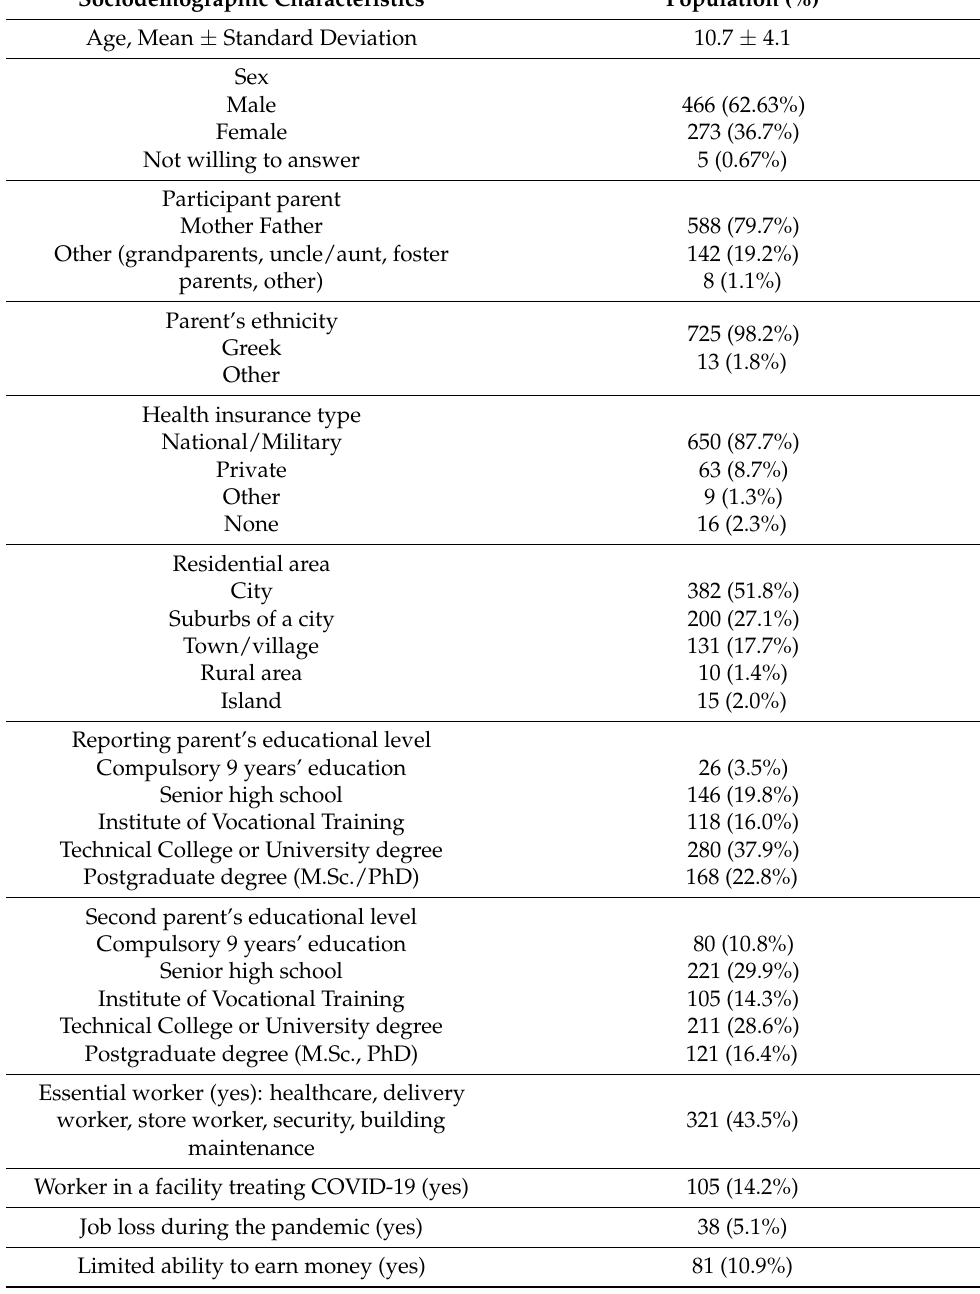
Table 3. Sociodemographic characteristics of the